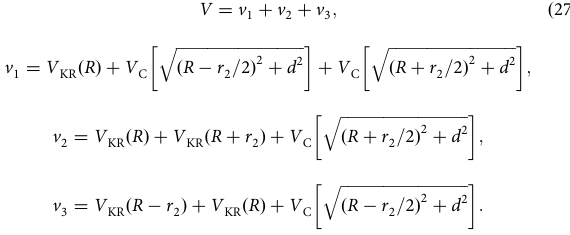
ffiffiffiffiffiffiffiffiffiffiffiffiffiffiffiffiffiffiffiffiffiffiffiffiffiffiffiffiffiffiffiffiffi ð R þ r = 2 Þ 2 þ d 2 2 ffiffiffiffiffiffiffiffiffiffiffiffiffiffiffiffiffiffiffiffiffiffiffiffiffiffiffiffiffiffiffiffiffi ð R (cid:2) r = 2 Þ 2 þ d 2 2